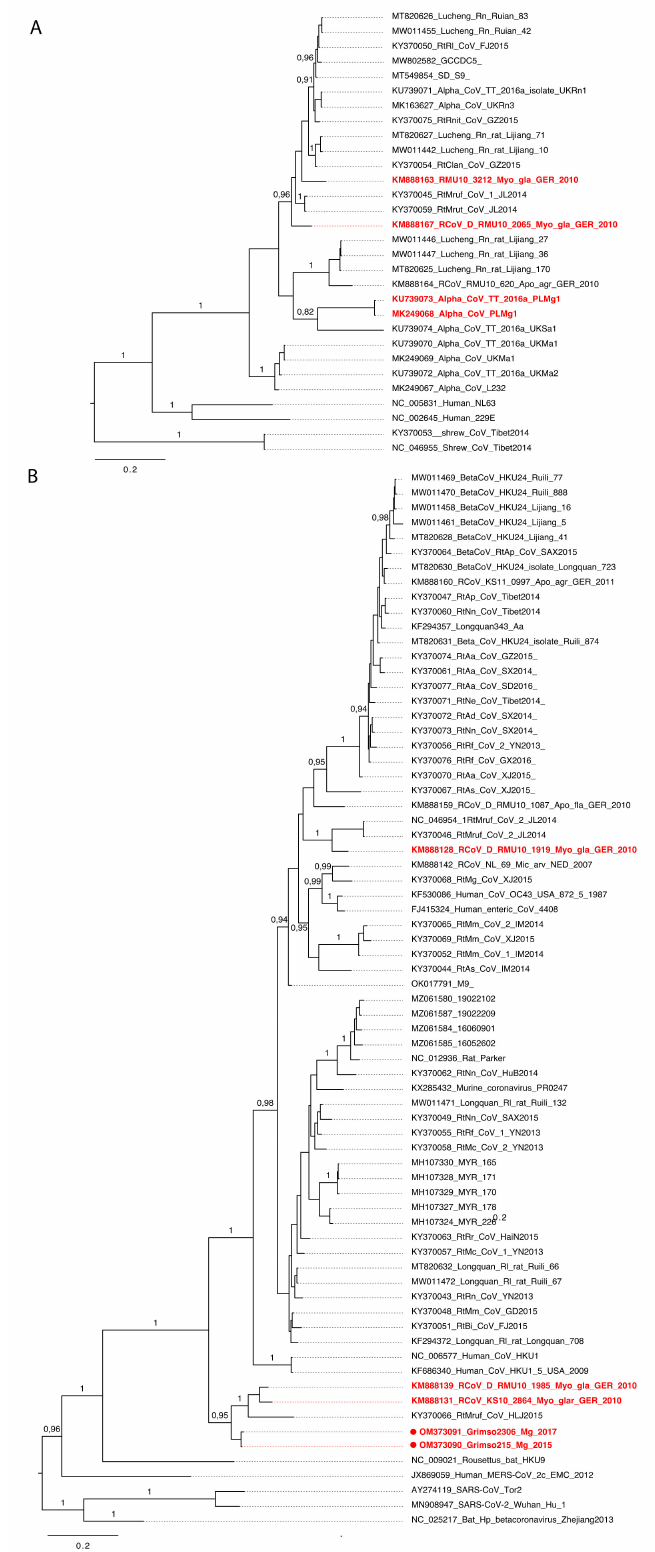
Figure 3. MrBayes tree based on 441nt of partial RdRp gene of CoVs. ( A ) Phylogeny of alphacoron- aviruses and ( B ) betacoronaviruses. The red color shows CoVs carried by bank voles across Europe. The scale bar indicates the nt substitution per site. The numbers above the branches indicate the posterior